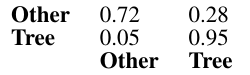
Table 3. S2 - PointNet 2 class